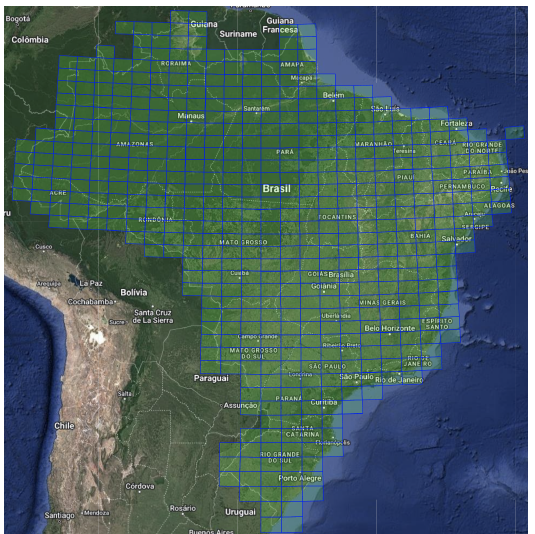
Figure 1. Tiling system of the Brazil Data Cube project. regular in time with one observation every 5 days, but the blue time series is